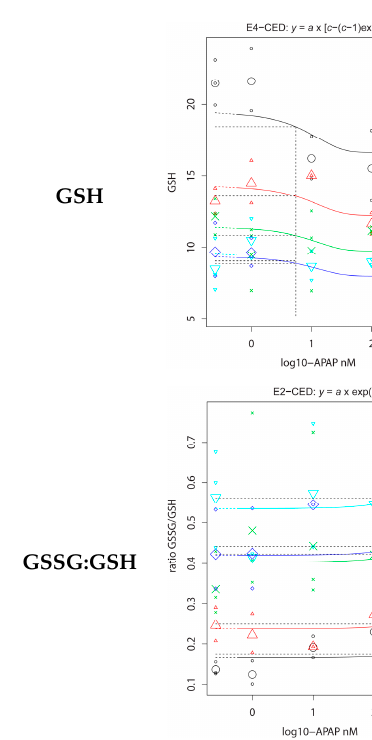
Figure 5. Dose-response analysis of background antioxidative parameters in the carcass of adult zebrafish exposed to cadmium during early embryonic life (0–72 hpf).